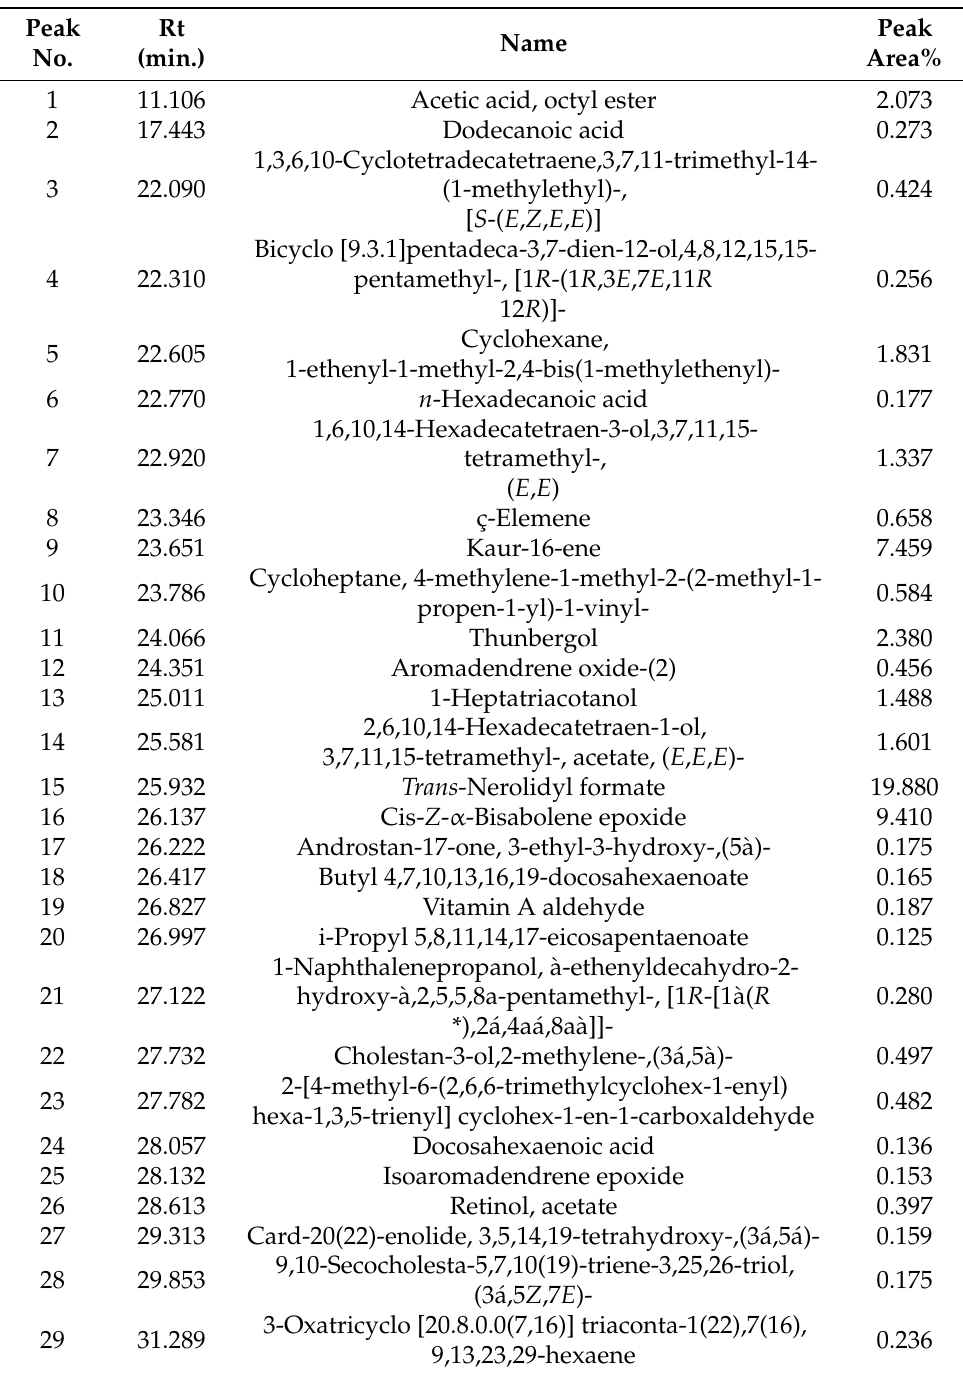
Table 1. Volatile phytoconstituents identified in the frankincense oleoresin ethanol extract by